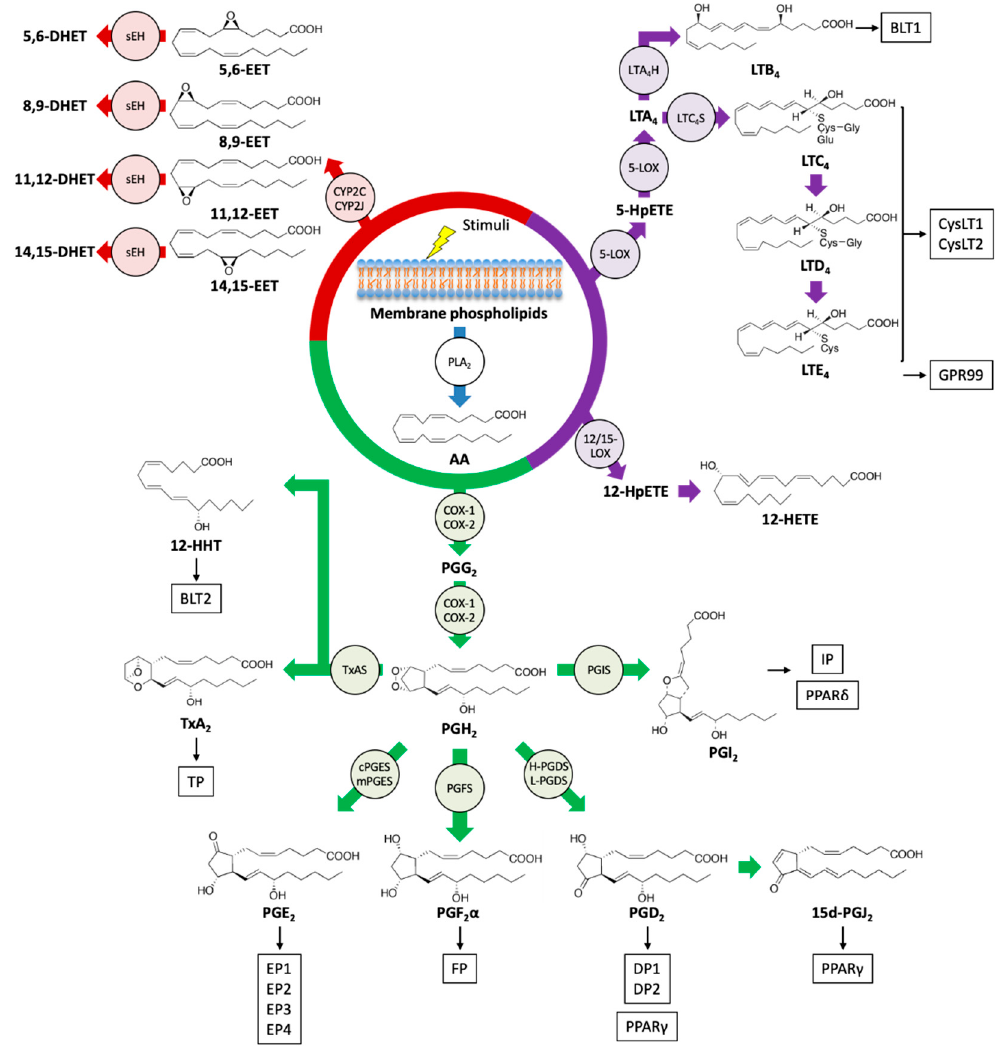
Figure 1. Biosynthetic pathways and receptors of eicosanoids. Upon stimulation, an omega-6 PUFA arachidonic acid (AA) is liberated from the phospholipids of the cell membrane by the action of phospholipase A 2 (PLA 2 ), and AA is metabolized into various bioactive lipid mediators. Prostanoids, leukotrienes (LTs), hydroxyeicosatetraenoic acid (HETEs), and epoxyeicosatrienoic acid (EETs) are formed from AA via cyclooxygenase (COX) (green), a lipoxygenase (LOX) (purple), and cytochrome (CYP) (red) pathways, respectively. Specific eicosanoid receptors and peroxisome proliferator-activated receptors (PPARs) that are potentially activated by eicosanoids are shown in boxes. sEH: soluble epoxide hydrolase; TxAS: thromboxane A synthase; PGIS: prostacyclin synthase; PGFS: prostaglandin F synthase; cPGES: cytosolic prostaglandin E synthase; mPGES: membrane-associated prostaglandin E synthase; H-PGDS: hematopoietic-type prostaglandin D synthase; L-PGDS: lipocalin-type prostaglandin D synthase; LTA 4 H: LTA 4 hydrolase; LTC 4 S: LTC 4 synthase; HpETE: hydroperoxyeicosatetraenoic